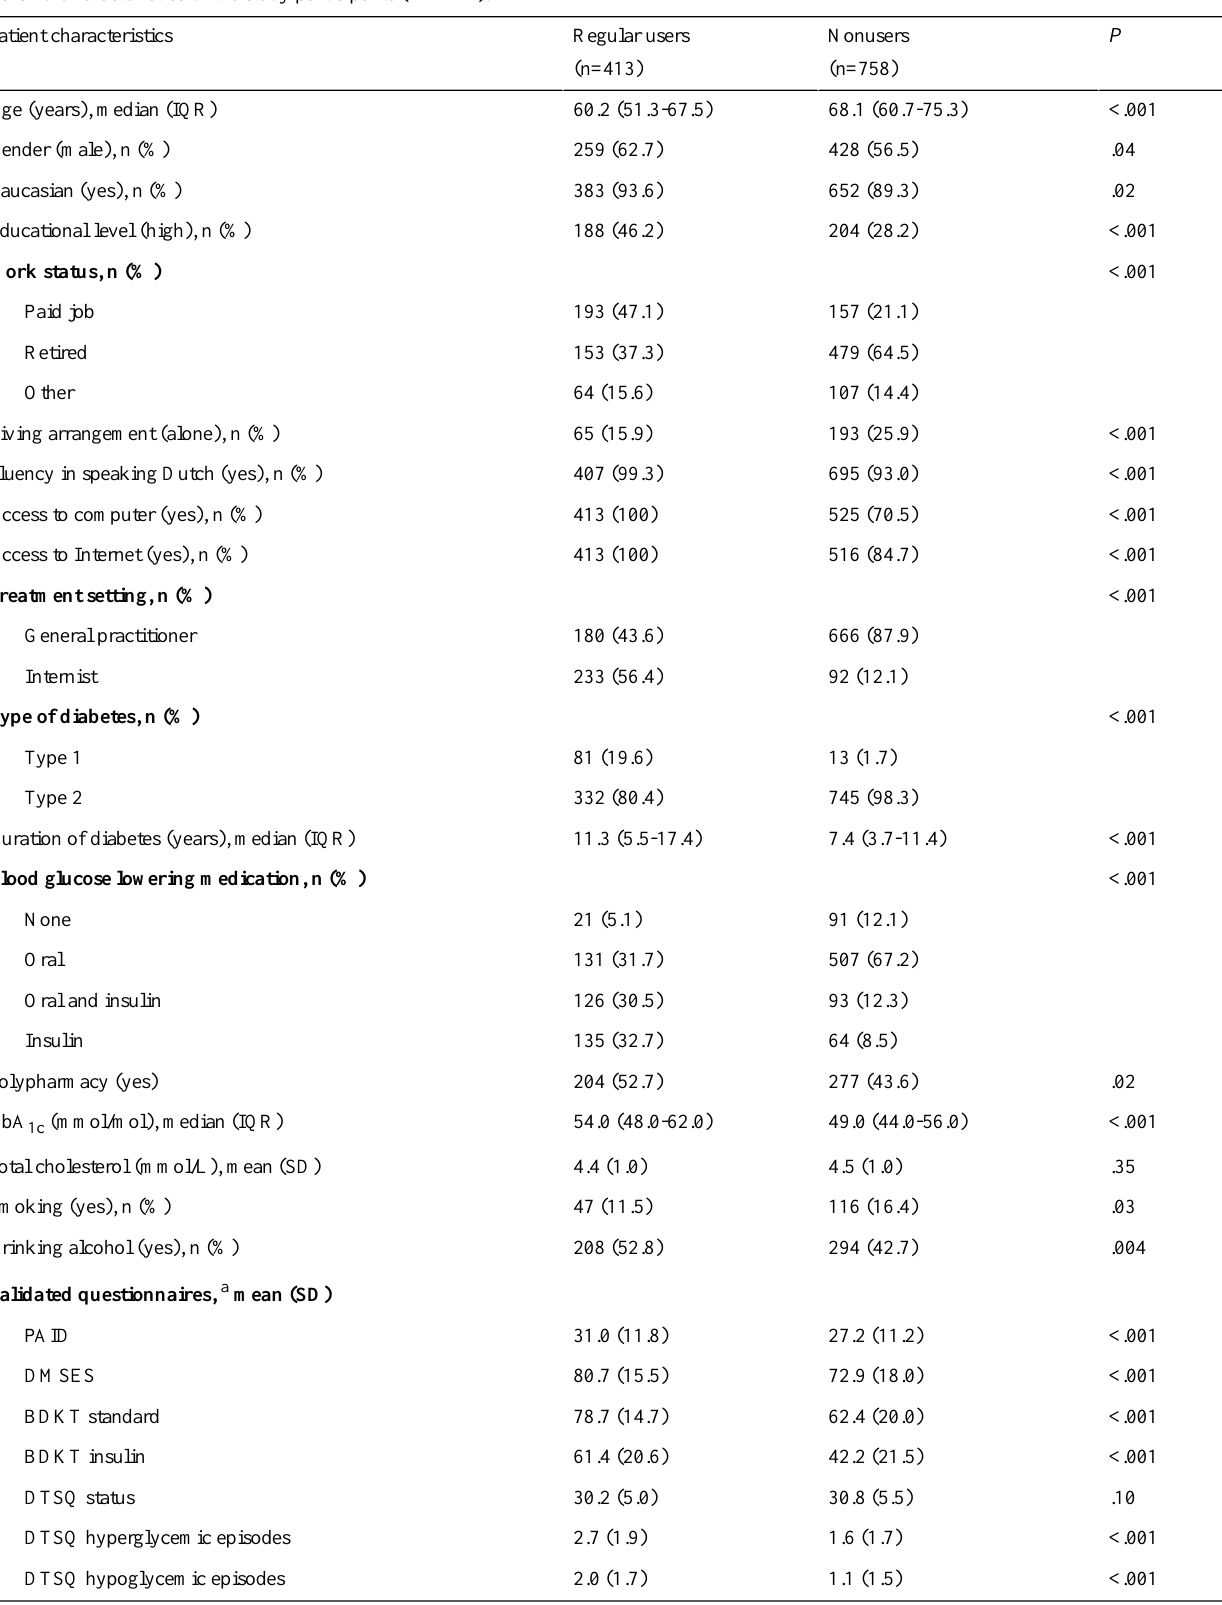
Table 1. Characteristics of the study participants (N=1171).